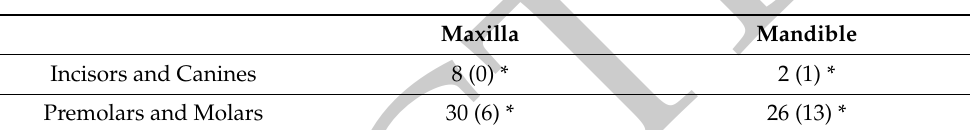
Table 1. Distribution of implants.